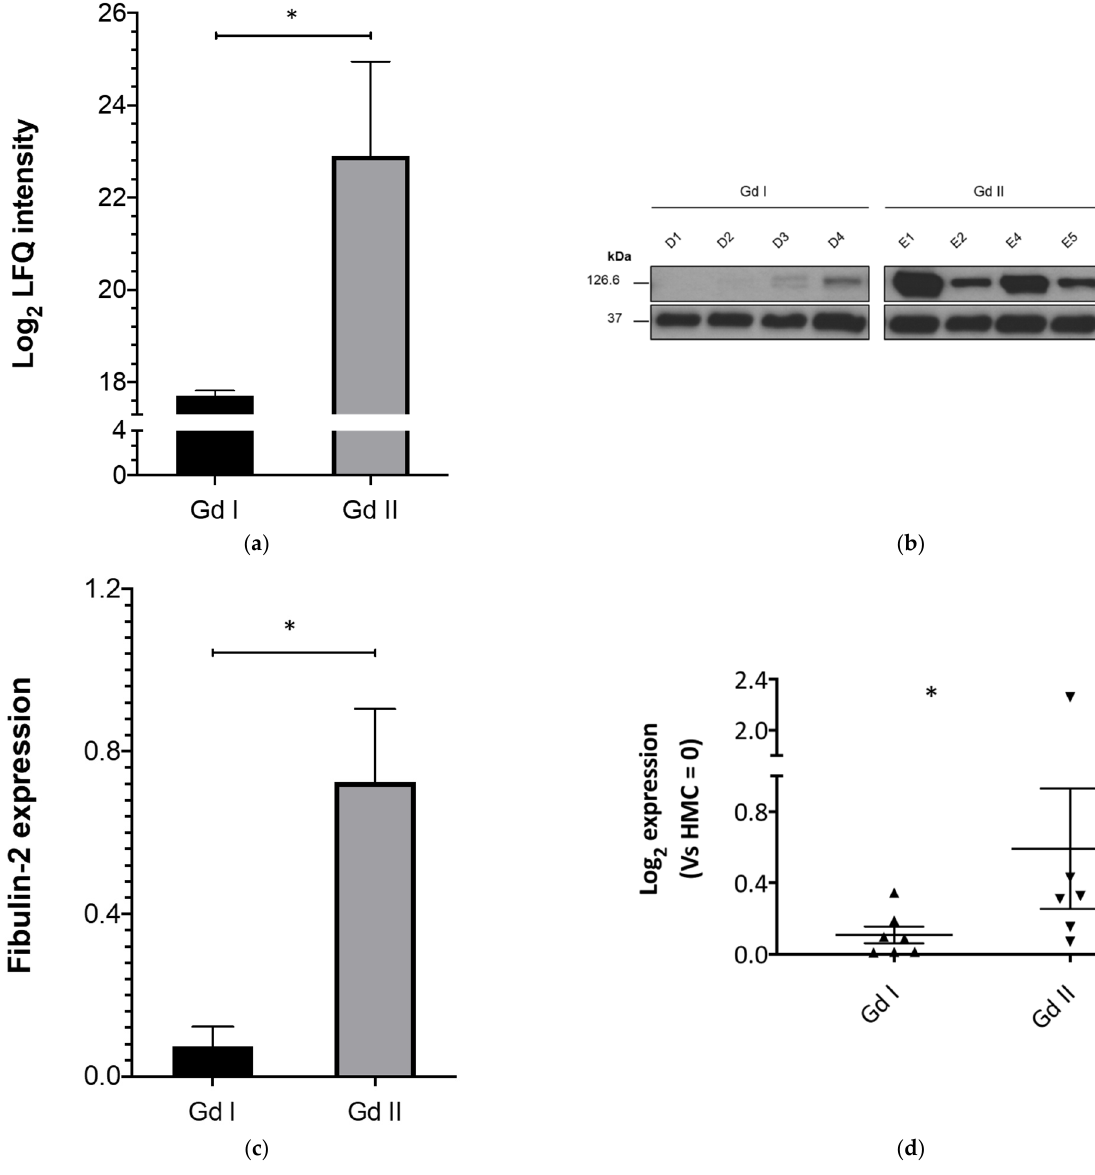
Figure 1. Fibulin-2 and FBLN2 are overexpressed/upregulated in grade II compared to grade I meningioma, in vitro. ( a ) Shows the mass spectrometry-derived Fibulin-2 comparative expression profile between grade I and II meningiomas; ( b ) representative Western blots of Fibulin-2 expression in grade I and II meningiomas; ( c ) shows Fibulin-2 expression in grade I ( n = 4) and grade II ( n = 4) meningiomas from the Western blot quantifications, normalized to GAPDH; ( d ) gene expression analysis by RT-qPCR of FBLN2 in meningioma primary cells. Data shown as Log 2-fold change (Fc) for grade I ( n = 7) and grade II ( n = 6) meningiomas. Data presented as mean ± SEM, * p < 0.05.